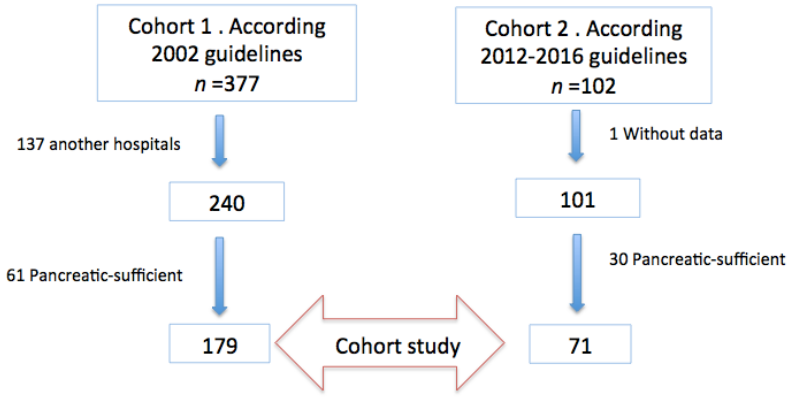
Figure 1. Summary of patient flow diagram.